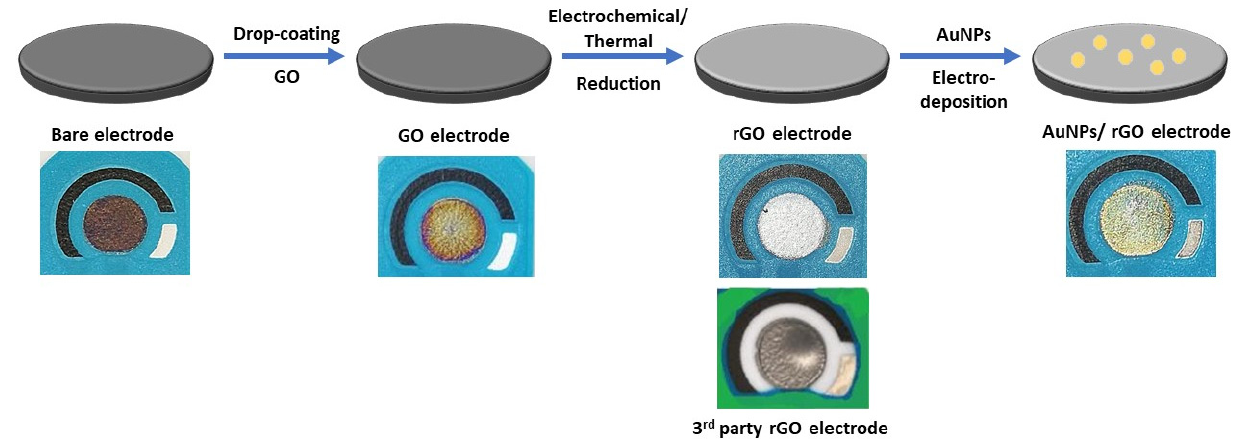
Figure A1. A schematic of the surface modification procedure of a screen-printed electrode (Section 2.3) and the changes to the appearance of the working electrode .